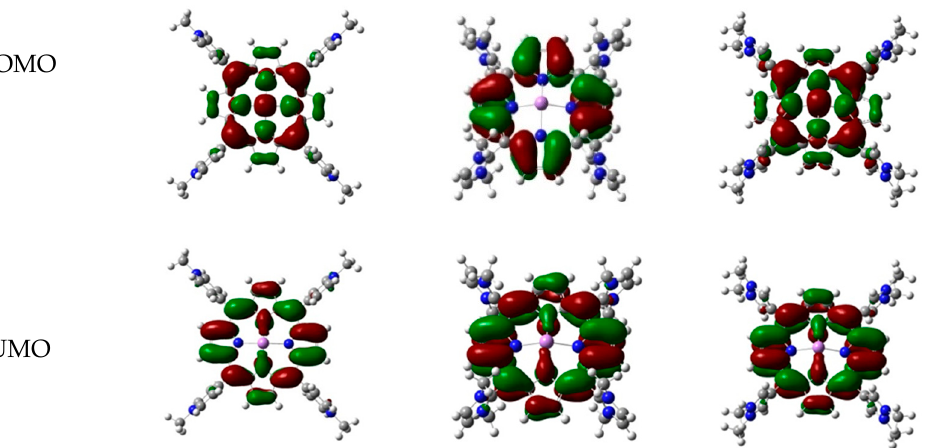
Figure 3. Electron distribution of As 3+ with TMPyP ( left ), TDMImP ( center ), and TDMPzP ( right ).